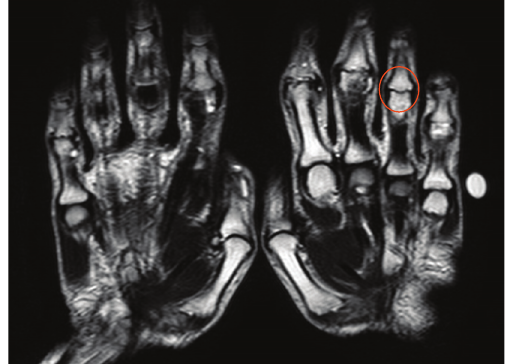
Figure 2: MRI of the proximal interphalangeal joints of both hands confirms sparing of the left ring proximal interphalangeal joint. All other proximal interphalangeal joints show marked synovitis and